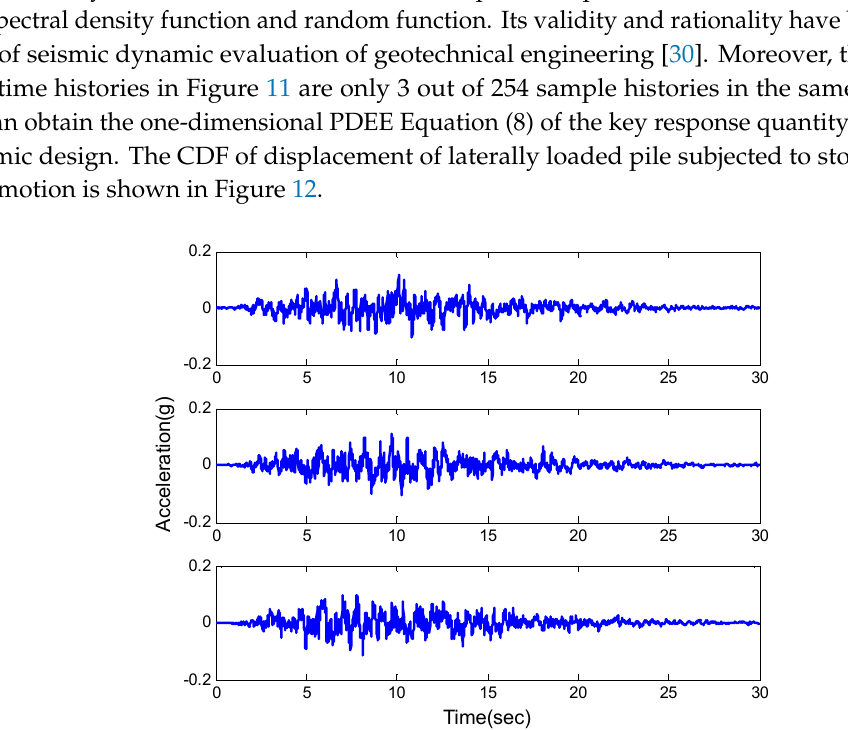
Figure 11. Typical time history samples of the seismic excitation input.